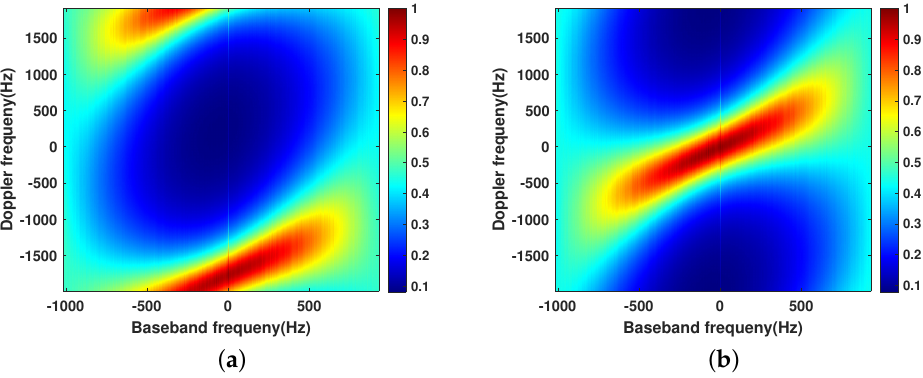
Figure 9. Doppler spectrum of GF − 3 dual − channel mode versus channel phase error. ( a ) Without channel errors calibration. ( b ) Using the proposed calibration